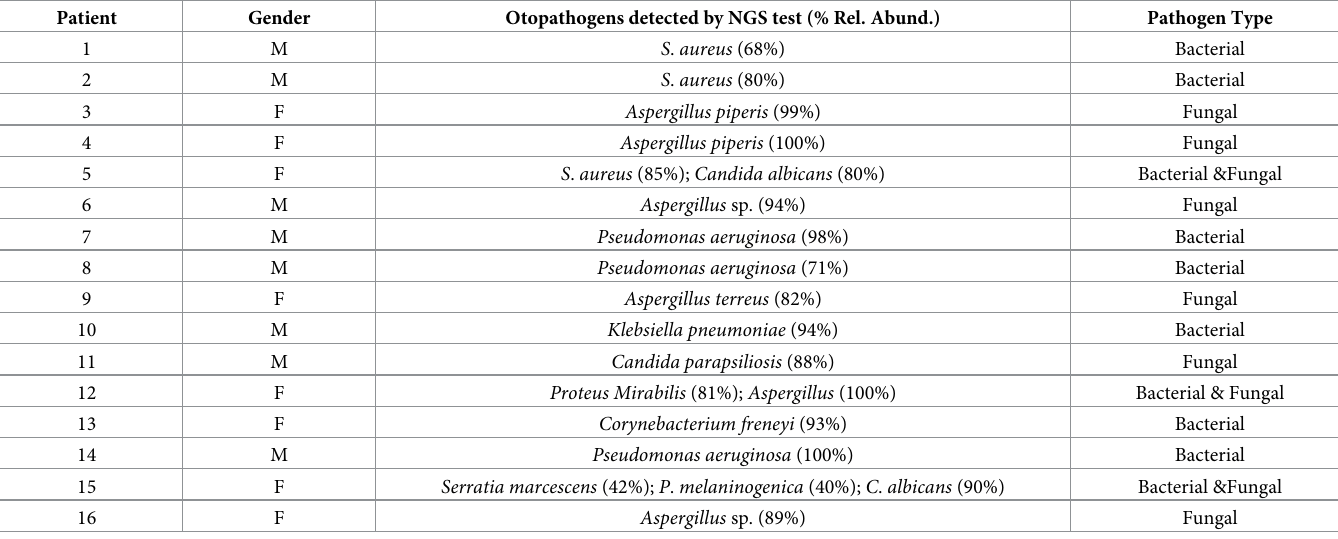
Table 2. Pathogens detected in otitis externa (OE) patients at high relative abundances.